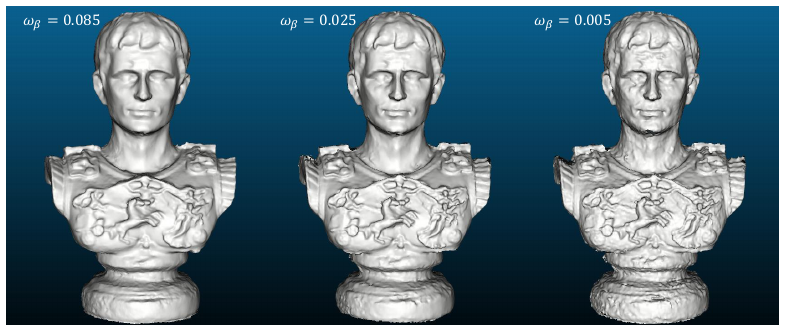
Figure 22. Normalized model deviation histograms and the cumulative distributions.